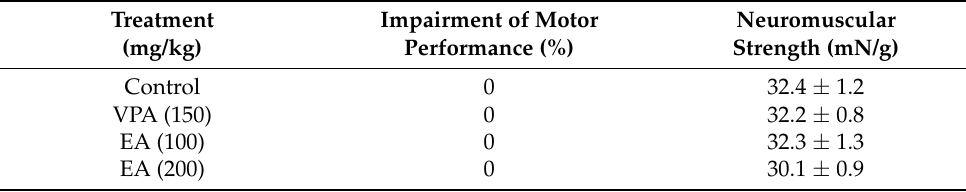
Table 1. Effect of EA on skeletal muscular strength and motor coordination in mice.